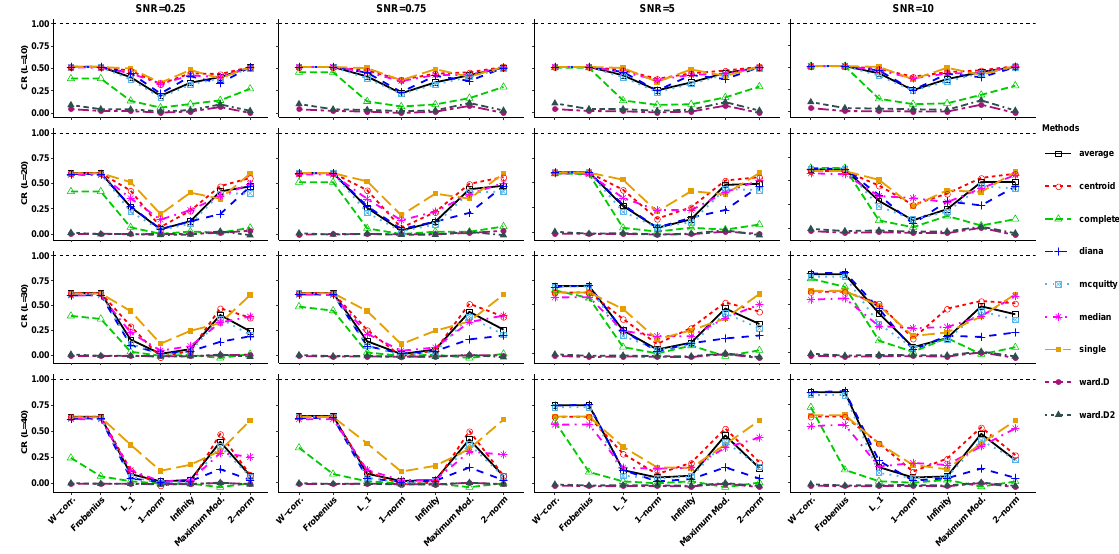
Figure 3. CR index for the linear series (case